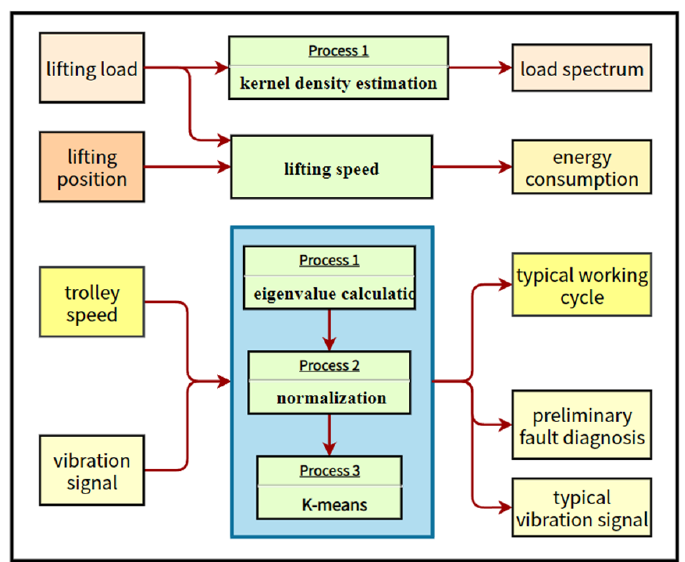
Figure 3. Data Mining Framework.